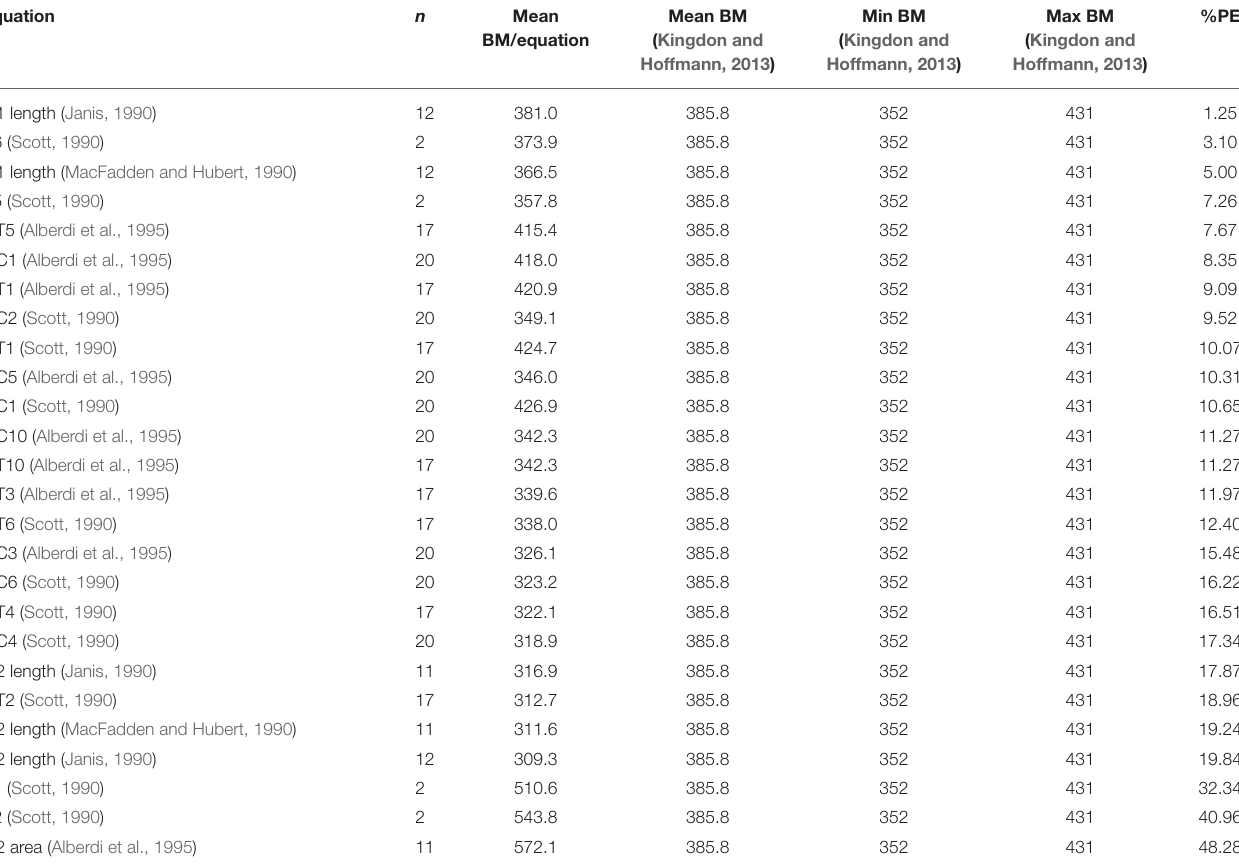
TABLE 2 | Body mass estimation equations ranked from “best” to “worst” based on percent prediction error (%PE) for skeletal and dental measurements of Equus grevyi .